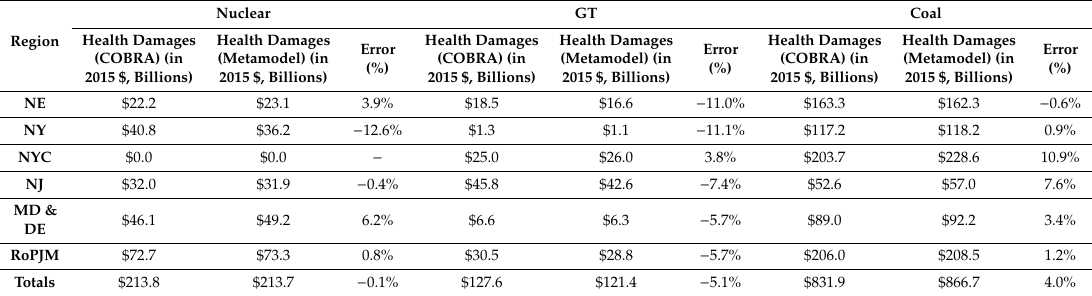
Figure 7. Health Damages by Region. Table 7. Comparison of Health Damage Values by Unit and Region.